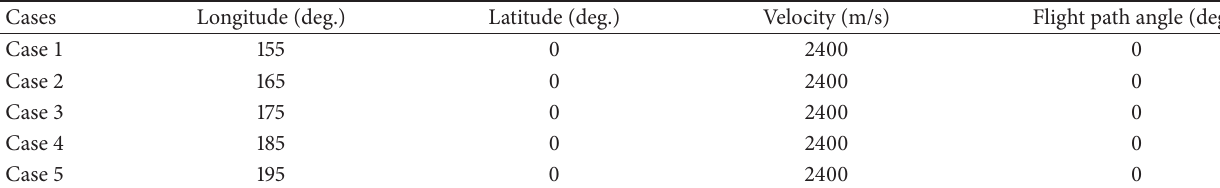
Table 3: Different terminal states for various cases.